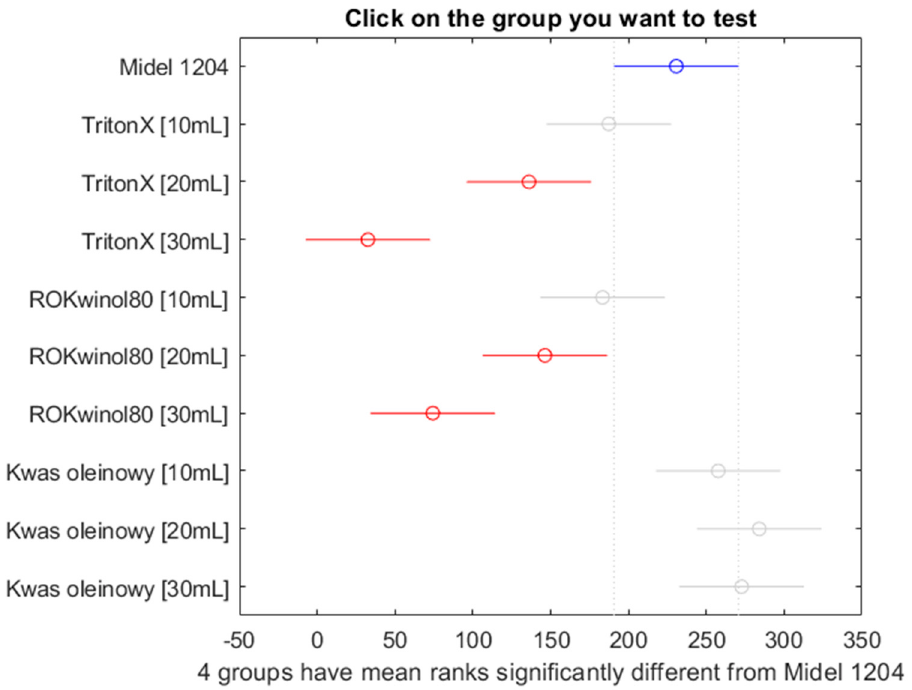
Figure 25. Post hoc Bonferroni test of Kruskal-Wallis test for all samples.